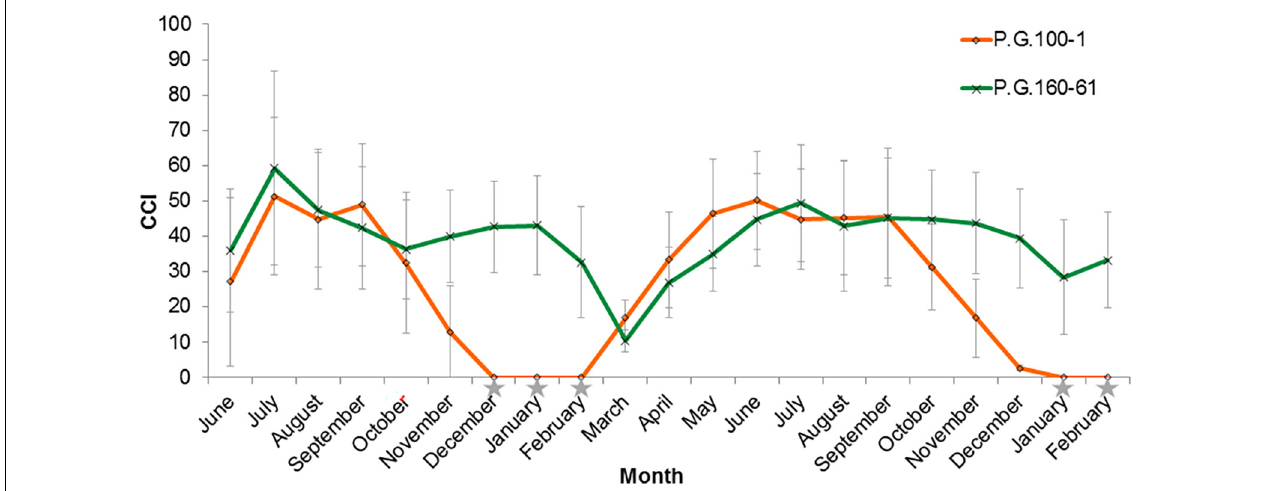
FIGURE 2 | Chlorophyll content in the leaves of two pomegranate varieties and their hybrids along 21 months. Chlorophyll content index (CCI; 0–100) was determined along 21 months in the leaves of P.G.100-1 (Orange line, diamond signs), P.G.160-61 (Green line, x signs). The graph shows the averages CCI of 70 leaves with STDEV. Gray stars represent measurments’ dates when the average minimum temperature was below 10 ◦